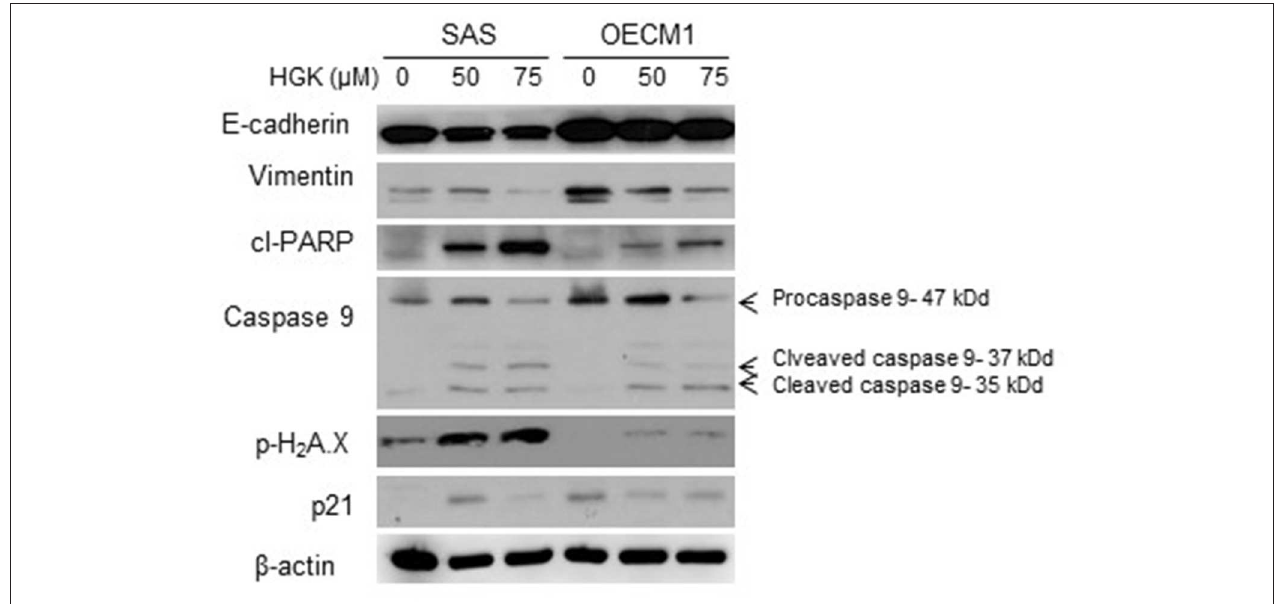
FIGURE 7 | Western blot analysis of cell cycle, apoptosis, and EMT regulatory proteins after treatment with HGK in SAS and OECM1 cells. β -actin was used as the internal marker.